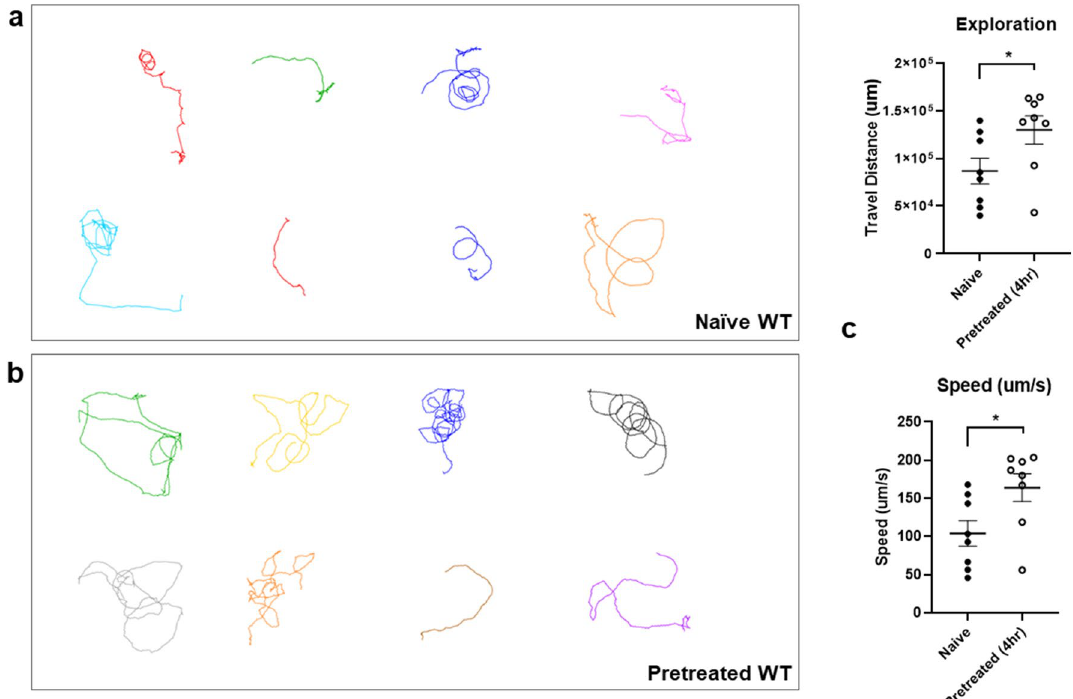
Figure 2. Ethanol pretreated animal is not defective in the locomotion. The locomotion trajectories of naïve ( a ) or ethanol-pretreated ( b ) animals on non-ethanol plate (with food, OP50) for 15 min are shown. ( c ) The stimulation of locomotion, increase of speed and travel distance, was observed in ethanol pretreated WT manner (Fig. 3c). The ethanol preference developed by pretreatment enabled WT animals to cross the Cu 2+ barrier in low concentration (2 mM, 5 mM), aversive stimuli that Naïve animal does not cross. However, while going from lower concentration to higher concentration of barrier (10 mM, 20 mM), ethanol pretreated animals failed to overcome the Cu 2+ barrier. 4 h pretreatment of ethanol was not enough to enable WT animals to cross the aversive Cu 2+ barrier to reach the ethanol area. Evidently, this change is strengthened with longer ethanol exposures (data not shown). Then we also introduced another aversive stimulus, denatonium benzoate as a bar- rier. Without pretreatment of ethanol, all the tested concentrations of denatonium barrier successfully block to interfere the naïve animals’ chemotaxis to ethanol. However, pretreated animals showed endurance against the denatonium barrier to reach the ethanol area and crossed the low concentration of obstacle (Fig. 3d). Since the compulsivity is defined as the urge to perform and persist to take a substance that escapes control despite serious negative consequences 62–64 , these results suggest that aversion-resistant ethanol seeking approach can be used as a proxy measure for the compulsive ethanol seeking behavior. Neuropeptide signaling orchestrates many complex behaviors in the brain, including compulsive behavior. Previously, we demonstrated the functional conservation of the neuropeptide corticotropin-releasing factor (CRF) system in responses to stress and ethanol in worms and mice 22 . We reported that seb-3, CRF (corticotro- pin-releasing factor) receptor-like G protein-coupled receptor of C. elegans facilitated the development of acute tolerance to ethanol and ethanol withdrawal symptom 22 . Since the CRF (corticotropin releasing factor) receptor function has been implicated in compulsive drug self-administration and stress-induced reinstatement of drug seeking in mammalian studies, we hypothesized seb-3(eg696) gain of function (gf) animals would also be able to exhibit enhanced alcohol seeking against the higher concentration of Cu 2+ barrier. A seb-3(eg696), dominant mutation, was suggested and functionally evaluated as a gain of function mutation due to its identity of mutation, which was single amino acid change in a conserved residue at the third intracellular loop, the binding region for G proteins 22,65–67 . First, ethanol preference of seb-3(eg696) animals and seb-3(tm1848) Knockout animals due to its deletion 22 was tested in the preference assay on ethanol-containing quadrant plates (Fig. 4a). Animals were allowed to move freely for 30 min between two control quadrants without ethanol and two ethanol quadrants. The naïve animals of WT, seb-3(eg696), and seb-3(tm1848) accumulated on non-ethanol regions. No significant ethanol preference was observed in naïve animals of all WT, seb-3(eg696), and seb-3(tm1848) (Fig. 4b). Remark- ably, seb-3(eg696) gf animals represented much faster and greater ethanol preference after ethanol pretreatment. Significant ethanol preference was observed in animals pretreated with ethanol for 2 h whereas WT animals did not (Fig. 4c). Additionally, greater development of preference was observed in seb-3(eg696) animals after 4 h ethanol pretreatment. Moreover, impaired development of ethanol preference was observed in ethanol pretreated seb-3(tm1848) animals (Fig. 4c) suggesting SEB-3 facilitated the ethanol preference. Subsequently, we conducted aversion-resistant ethanol seeking assay with seb-3 mutant animals. Quantification of seb3(eg696) gf mutant ani- mals’ motivational drive to seek ethanol showed enhanced aversion-resistant ethanol seeking behavior compared